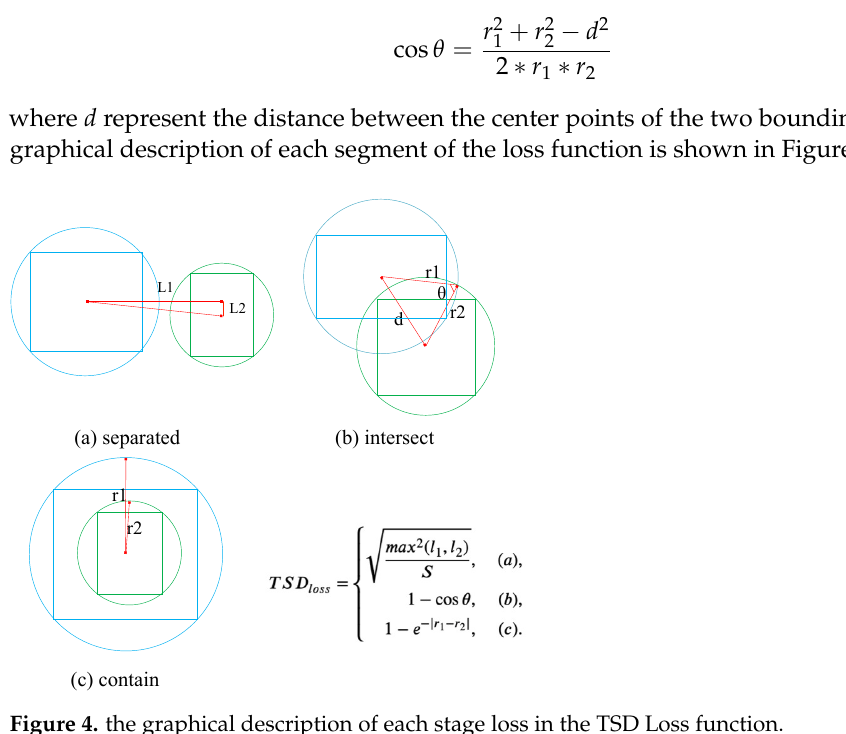
Figure 4. the graphical description of each stage loss in the TSD Loss